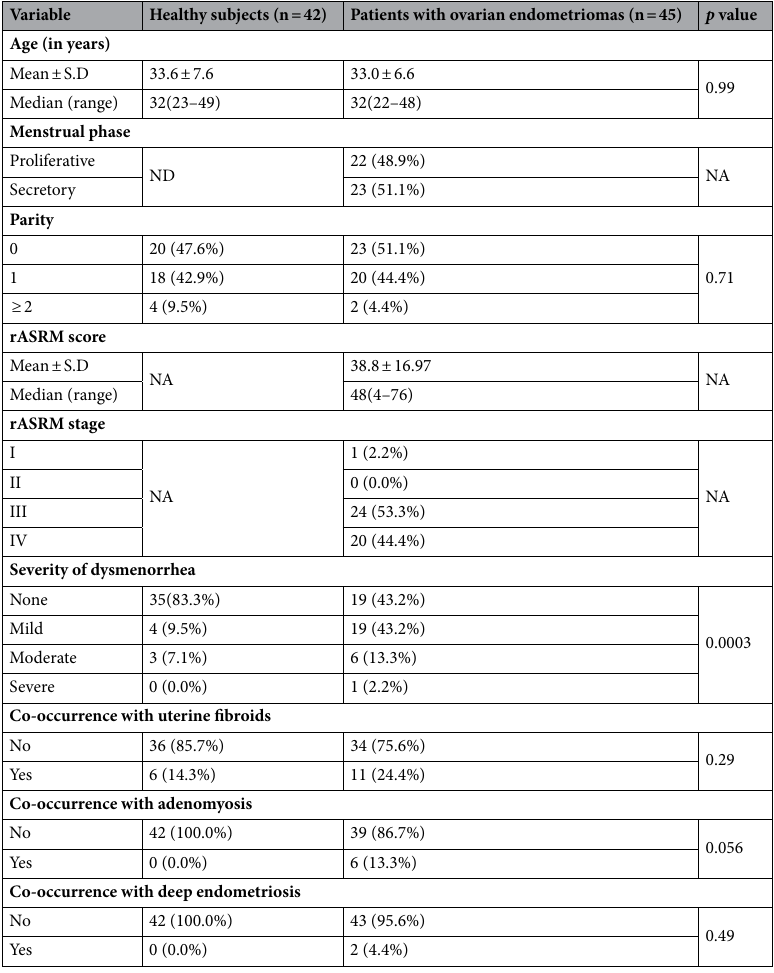
Table 1. Characteristics of recruited subjects in this study. rASRM revised American Society for Reproductive Medicine classification system for endometriosis, ND not determined, NA not